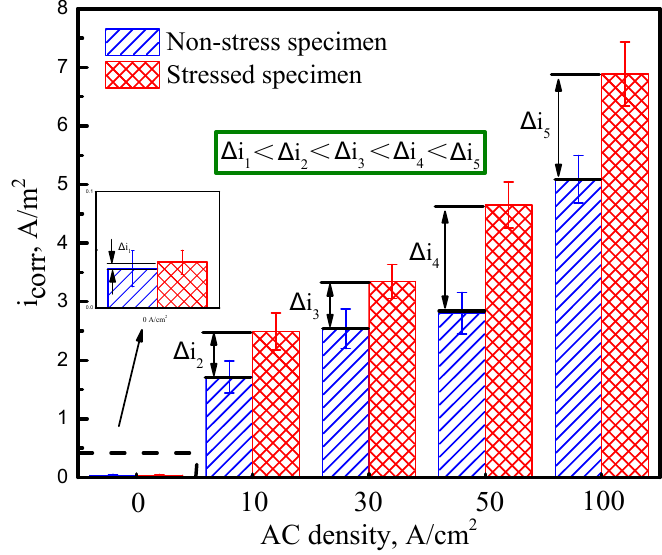
Figure 5. Corrosion current density of the X70 steel tested at various AC densities in simulated seawater.